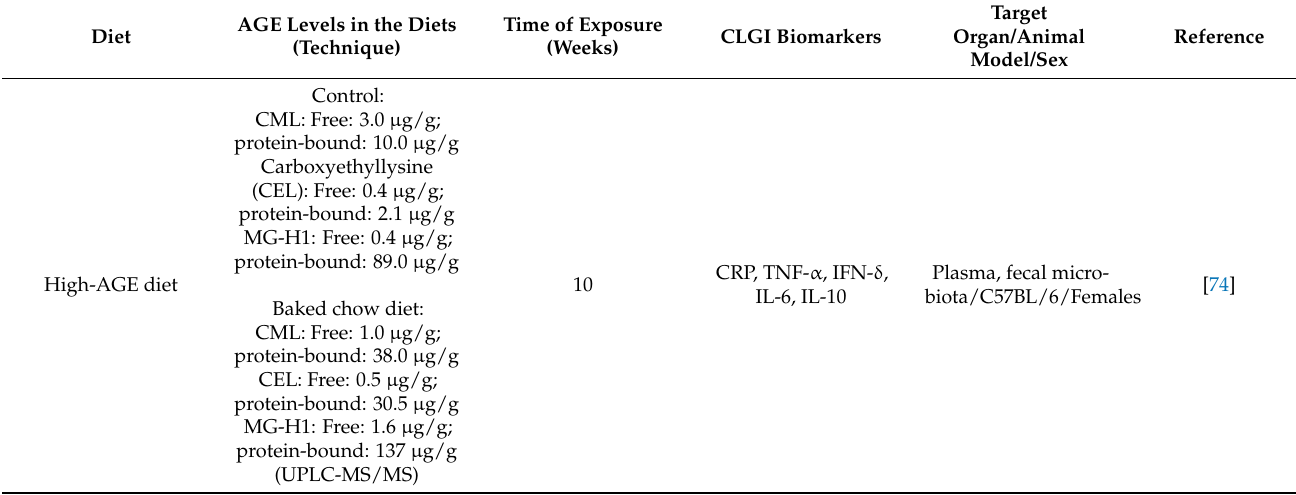
Table 2. Studies (in reverse chronological order) of CLGI induction by Advanced Glycation End-Products in murine models. AGE Levels in the Diets Time of Exposure CLGI Biomarkers Diet (Technique) (Weeks)